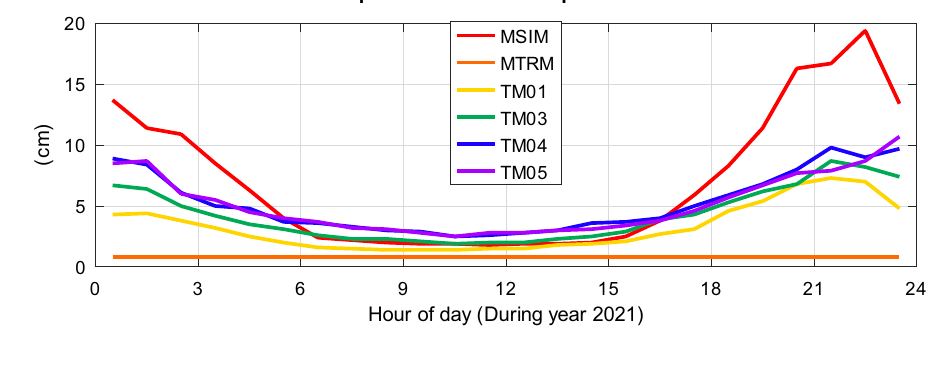
Fig. 5 Spatial decorrelation of ionospheric delay observed on the GPS PRN23 based on the NRTK station pair data (station separation from 36 to 62